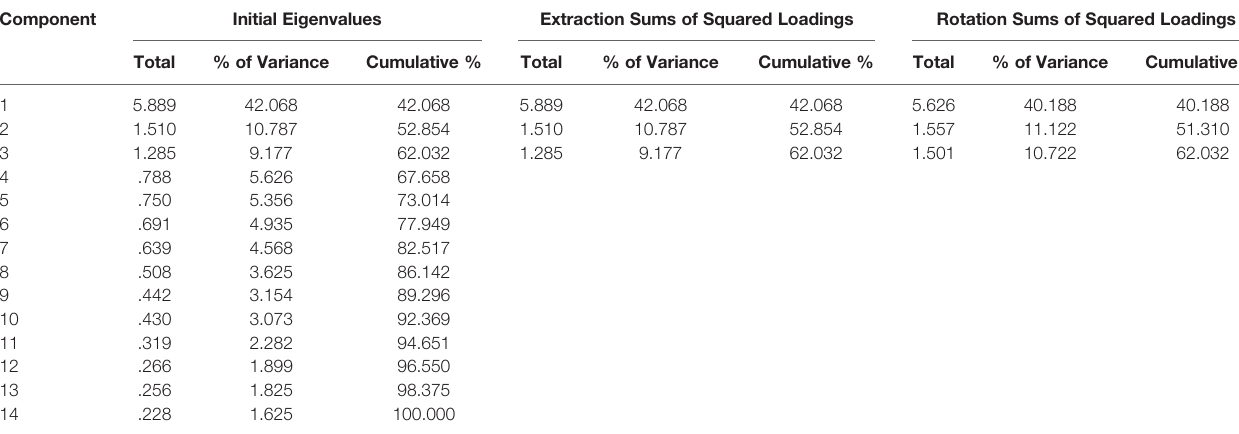
TABLE 3 | Eigenvalues and percentage of total variance explained in exploratory factor analysis. Component